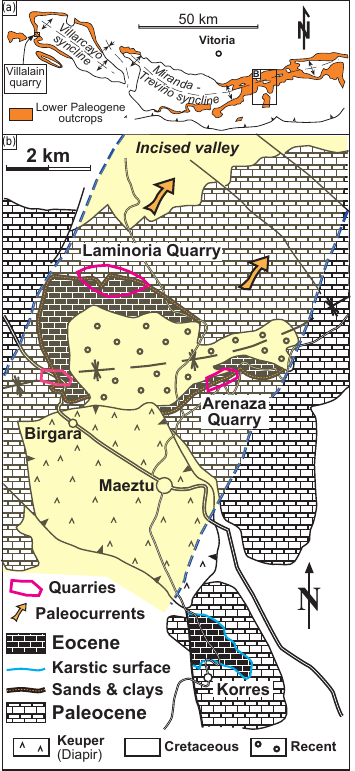
Figure 3. Panel (a) : lower Paleogene outcrop map of the southwest- ern Pyrenees, with location of the Laminoria–Korres area and the Villalain quarry. Panel (b) : enlarged outcrop map of the Laminoria– Korres area, with an interpretative plan view of the Laminoria in- cised